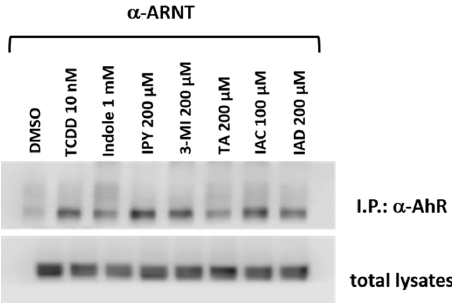
Figure 6. MICTs induce a formation of the AhR-ARNT heterodimer. Intestinal LS180 cells were incubated with TCDD, tested MICT, and vehicle (DMSO; 0.1% V / V ) for 90 min. Protein co-immunoprecipitation of ARNT was carried out, as described in the Methods section. The representative immunoblots of immuno-precipitated protein eluates and total cell lysates are shown. The experiments were performed in two consecutive cell passages.